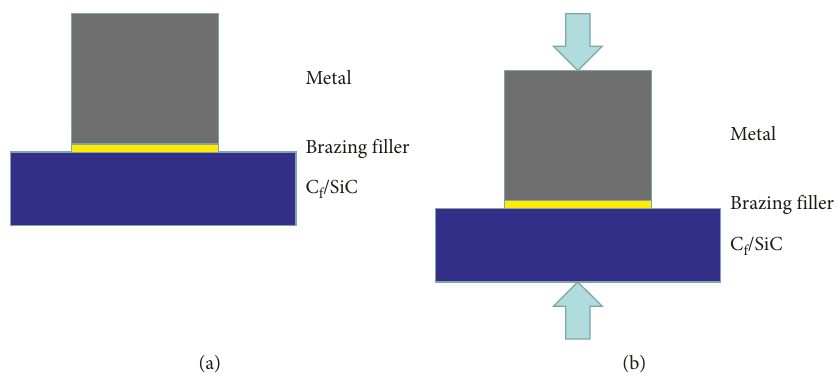
Figure 7: The schematic diagram of (a) brazing method and (b) diffusion bonding